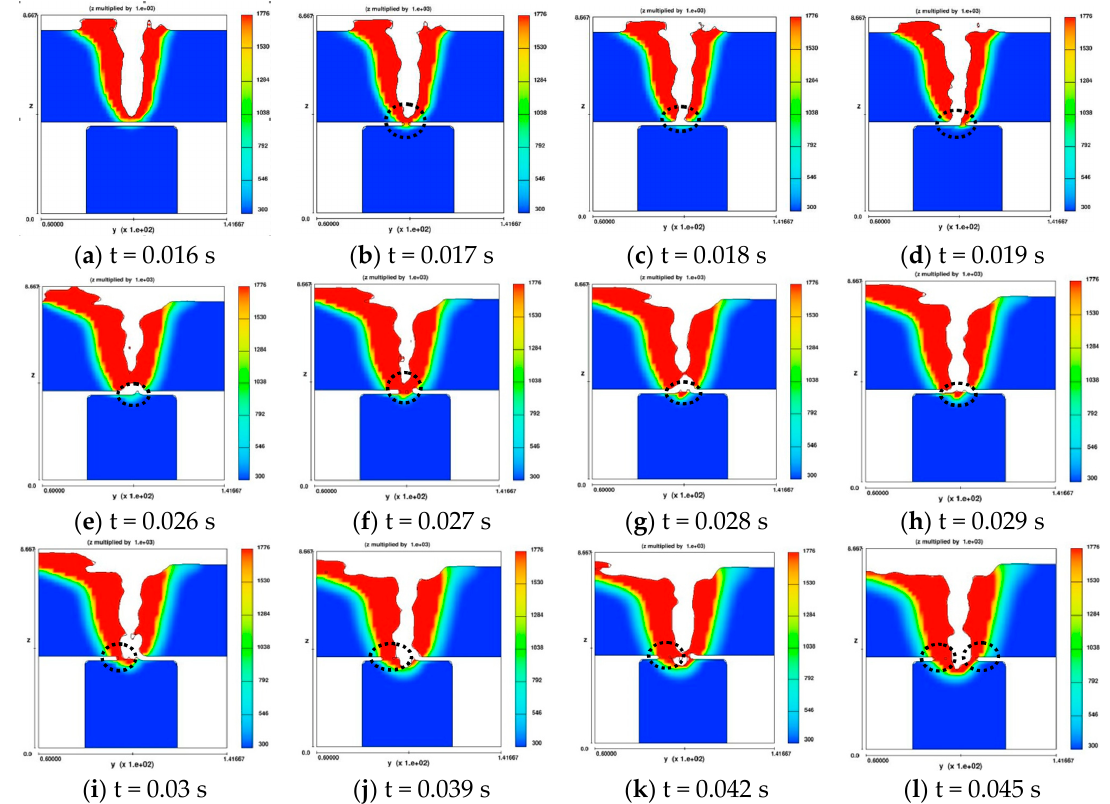
Figure 3. The pool connecting mechanism in the gap location along the x-z plane.